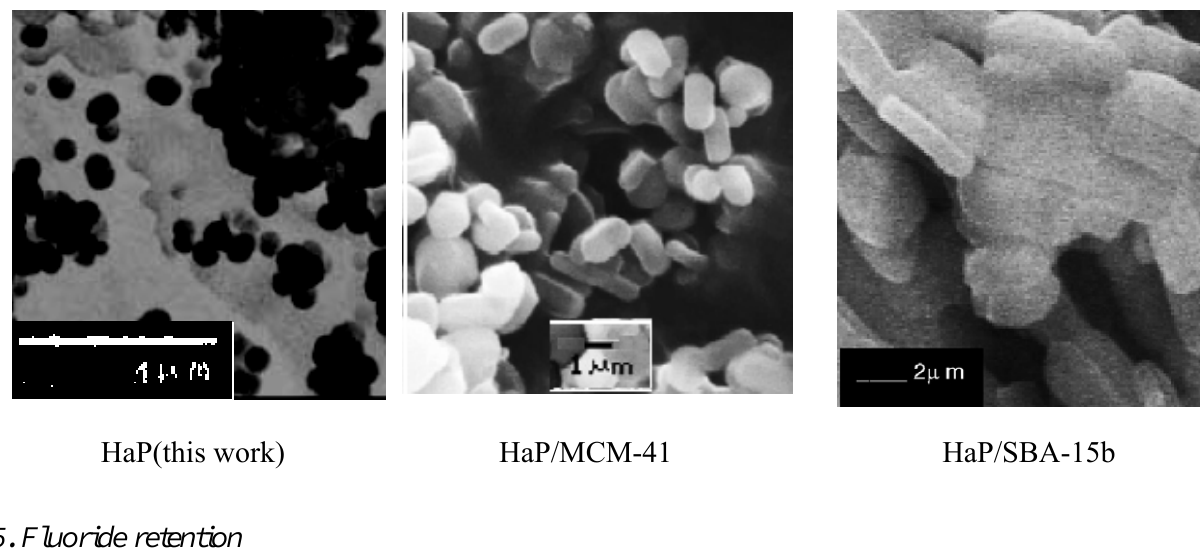
Figure 6. SEM of HaP, HaP/MCM-41 and